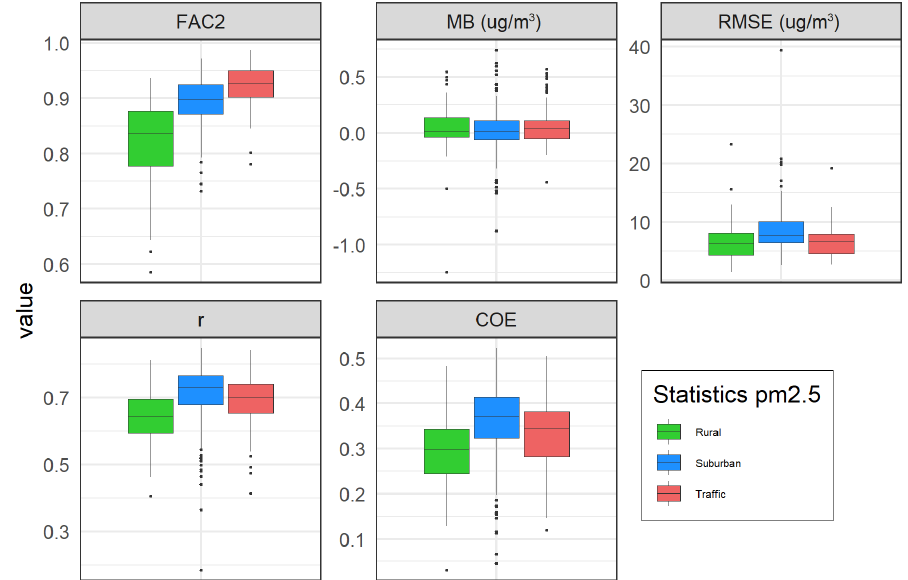
Figure 13. Box plots of evaluation parameters from the cross-validation for 2005–2019 (again for the same three types of stations).